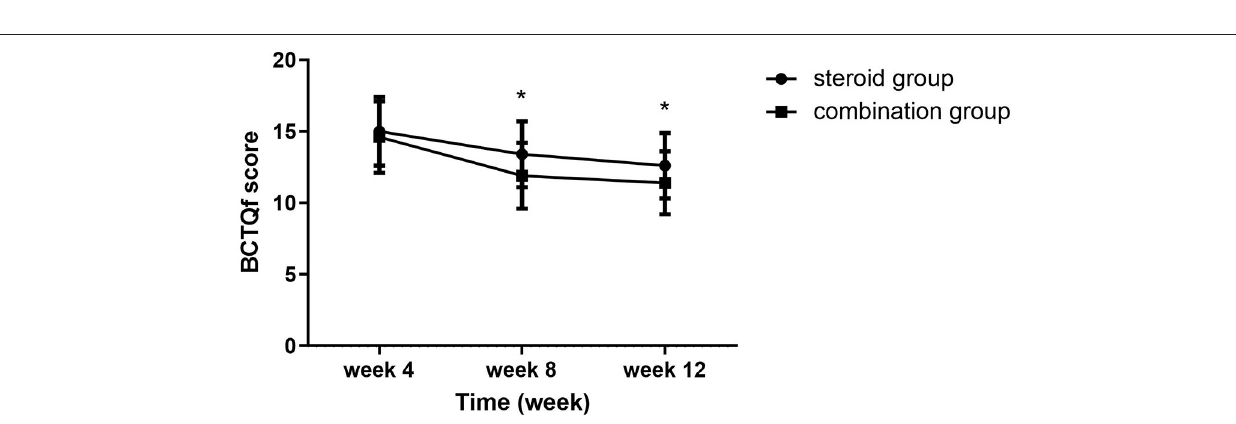
FIGURE 4 | BCTQf at 4-, 8-, and 12-week follow-up between the steroid and combination groups (mean ± SD). The differences were significant at weeks 8 and 12 (* P ≤ 0.01, ANOVA with subsequent post-hoc Bonferroni test was used). BCTQ, Boston Carpal Tunnel Syndrome Questionnaire; f,